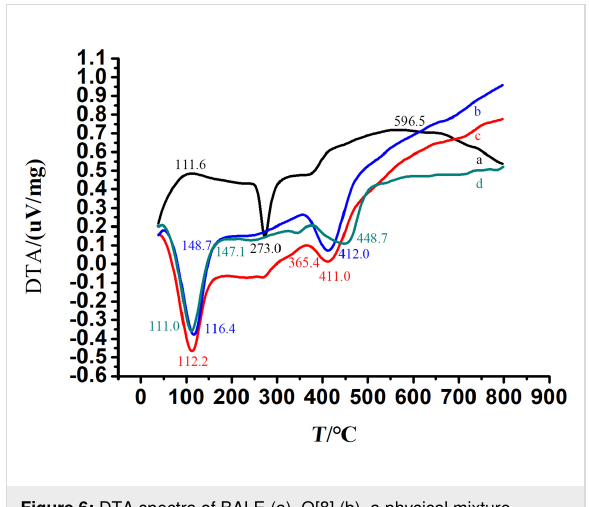
Figure 6: DTA spectra of BALE (a), Q[8] (b), a physical mixture Q[8]-BALE (N Q [8]/N BALE = 1:1) (c) and the BALE–Q[8] inclusion com- plex (d).